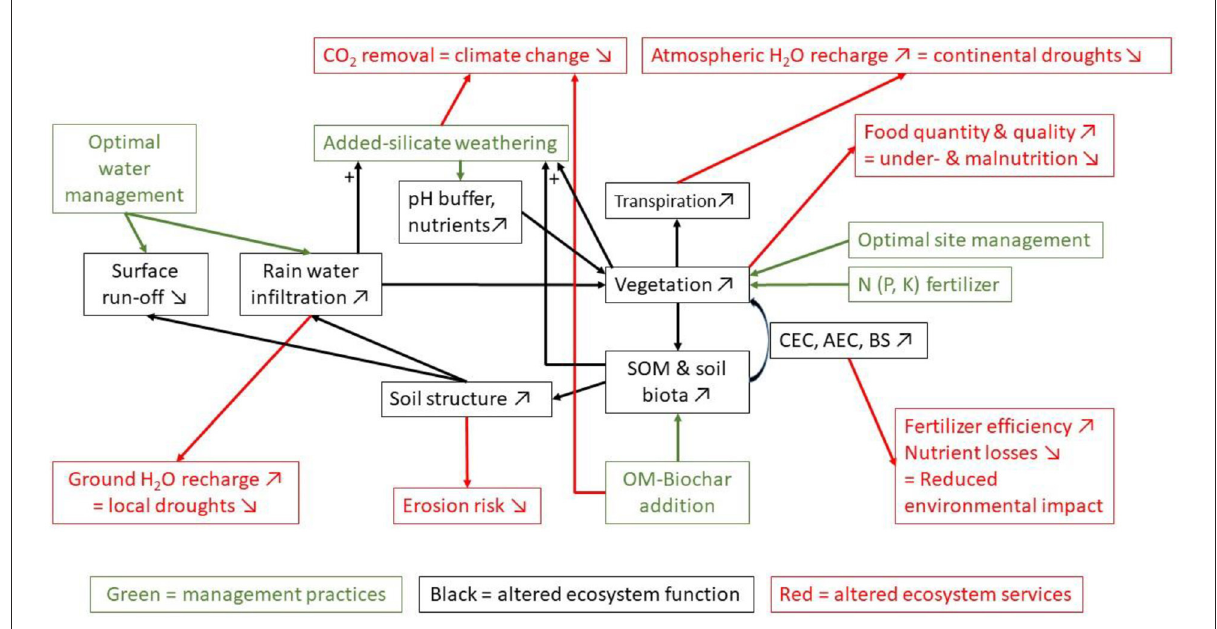
FIGURE1 Overview of how combining CDR techniques to form new fertile soils would support functions and services in agricultural soils. CDRs and site management practices are given in green, effects on ecosystem services in red, and effects on ecosystem processes in black. Weathering of the added silicates releases a suite of nutrients and buffers soil pH, both benefiting vegetation growth. Plant growth must be supported by well-balanced addition of (in)organic fertilizers and site-specific management such as crop selection and engineered surfaces. Nutrient and water losses are best avoided through high inputs of organic matter (OM) or biochar from renewable biomass caches. These will increase cation- and anion exchange capacity (CEC and AEC) and base saturation (BS) of soils, as well as reinforce its biotic community leading to aggregate formation and improved soil structure. The latter not only protects against surface erosion, it also increases water infiltration, avoiding losses by overland flow and maximizing water retention, which stimulates plant growth. Optimal management of water through reservoirs, wells and irrigation systems further reduces water losses and increases plant-available water which helps to secure yields during extreme